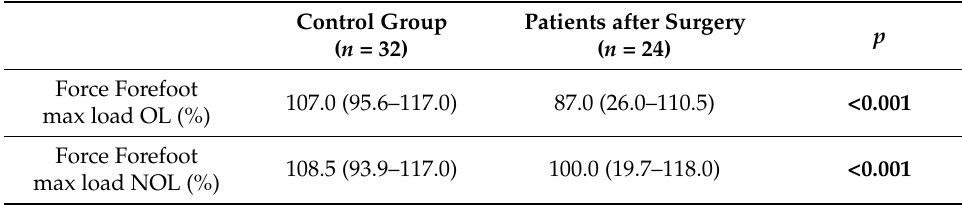
Table 1. Gait parameters for patients after treatment with the Ilizarov method vs. healthy control